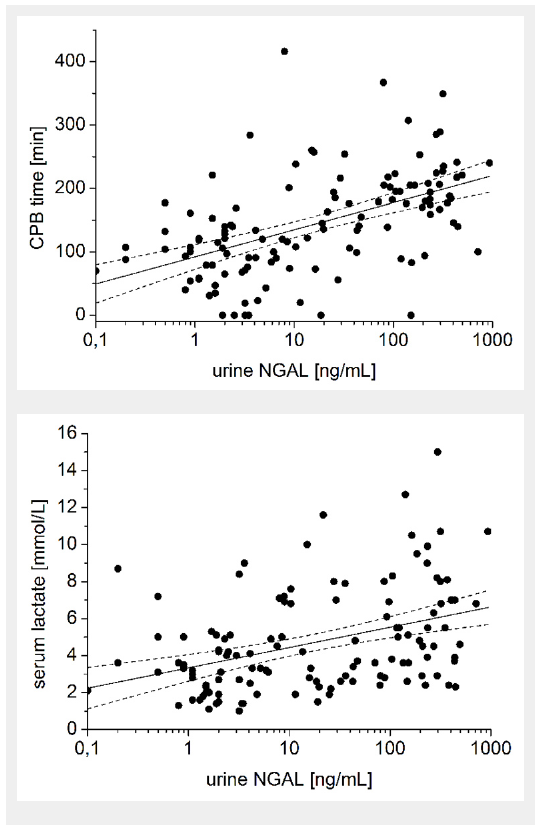
Correlations between urine NGAL 2 hours after the end of cardiopulmonary bypass (CPB) and (a) duration of CPB (P <0.01), and (b) serum lactate concentration (P <0.01). Solid and dotted lines represent the regression line and the 95% confidence interval,